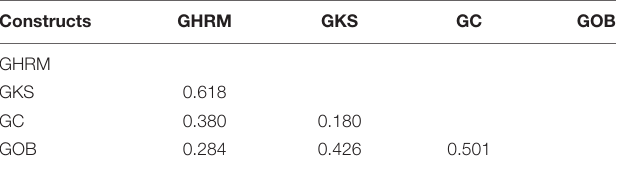
TABLE 3 | Measurement model convergent validity. TABLE 4 | Discernment validity: HTMT